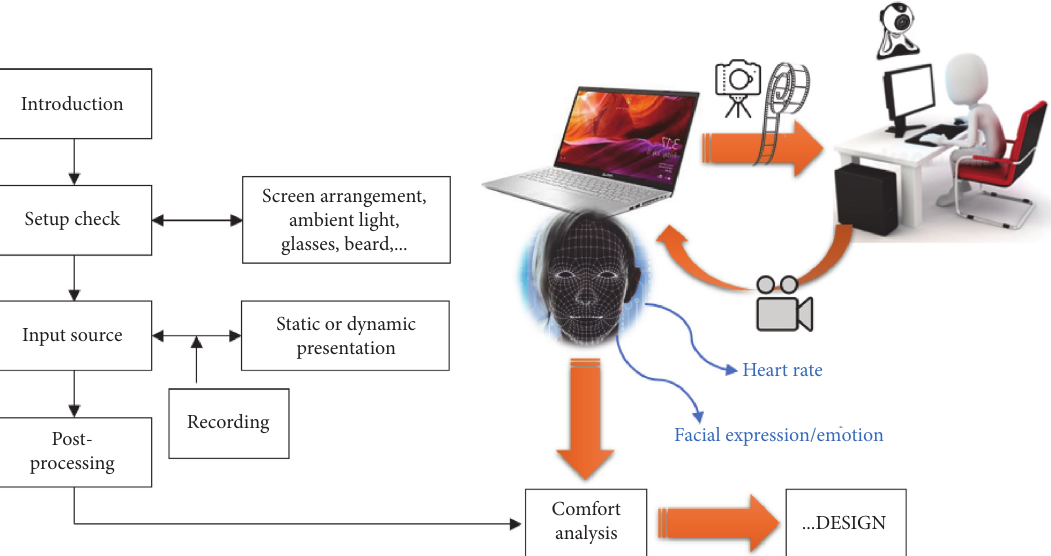
Figure 4: Flowchart for the virtual experimental investigation.